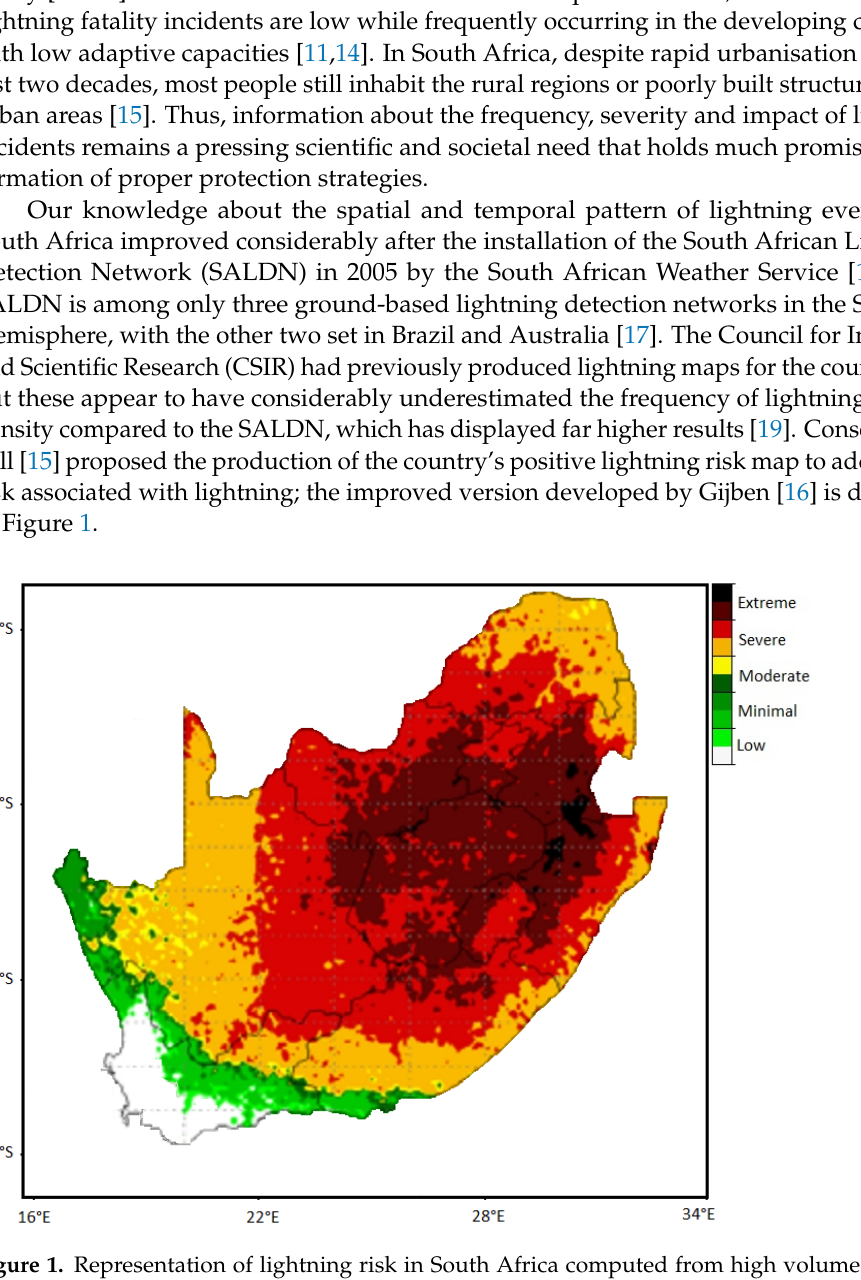
Figure 1. Representation of lightning risk in South Africa computed from high volumes of lightning and lightning with positive polarity data (2006–2010) (modified from Gijben [16], copyright permission has been received).